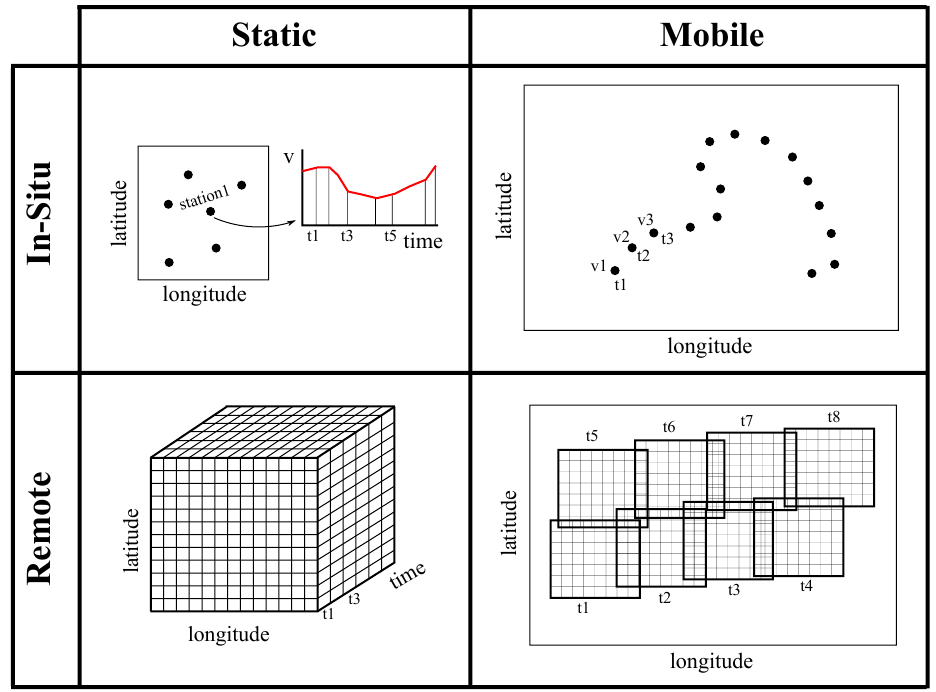
Figure 8. Observations obtained from environmental sensors of different